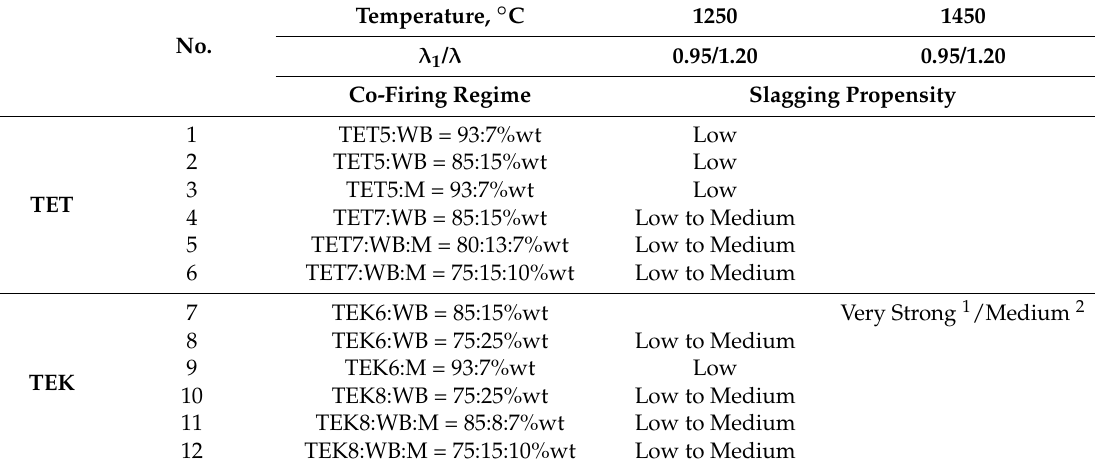
Table 3. Evaluation of slagging.